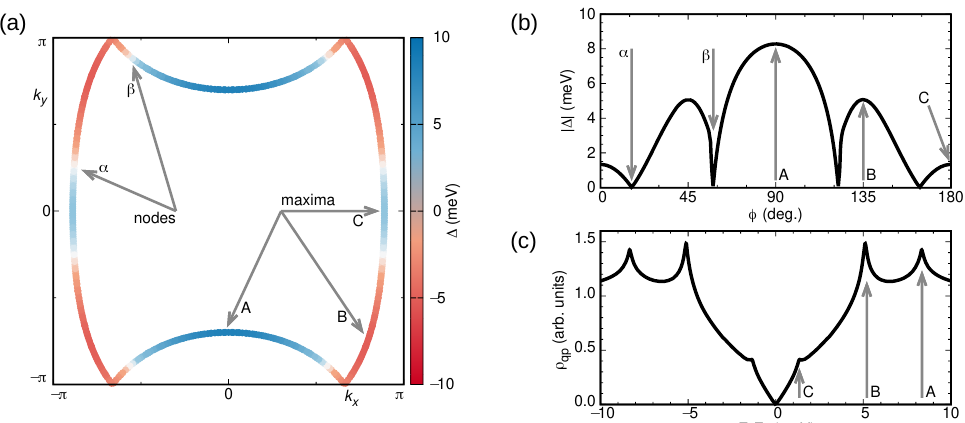
Figure 7. Theoretical results for κ -(BEDT-TTF) 2 Cu[N(CN) 2 ]Br, calculated by an RPA spin-fluctuation approach using hopping parameters extracted from ab-initio-based density functional theory calcu- lations in the extended molecular model: ( a ) Eight-node mixed-symmetry superconducting gap ∆ , ( b ) | ∆ | as a function of the angle φ with respect to k x , ( c ) quasi-particle DOS ρ qp in the superconduct- ing state. The three coherence peaks A, B, C are consistent with scanning tunneling spectroscopy results [60]. Figures adapted from Ref.